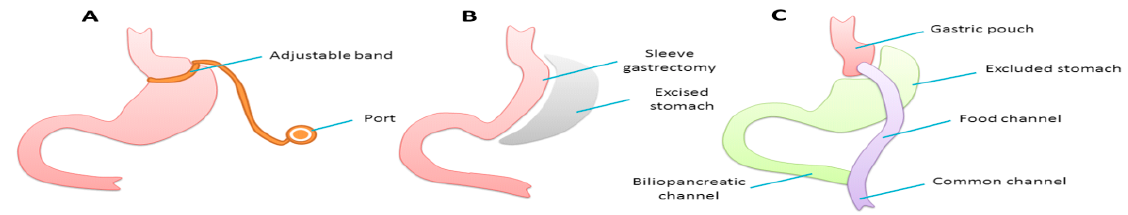
Figure 1. Common types of bariatric surgery: adjustable gastric banding ( A ); sleeve gastrectomy ( B ); and Roux-en-Y gastric bypass ( C ).